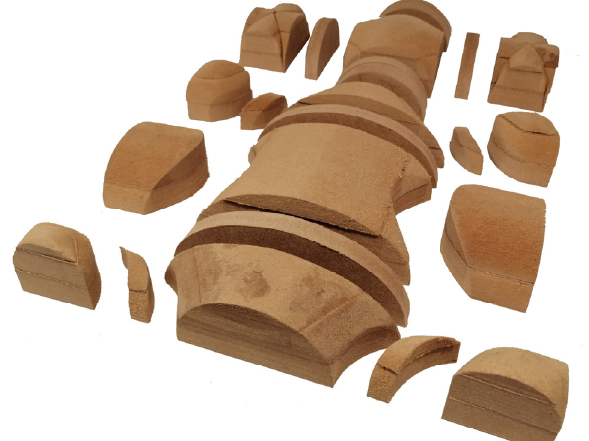
Figure 13 . Wooden physical model aimed to tactile experience of the vault of Palazzo Mazzonis atrium. Digital prototyping: